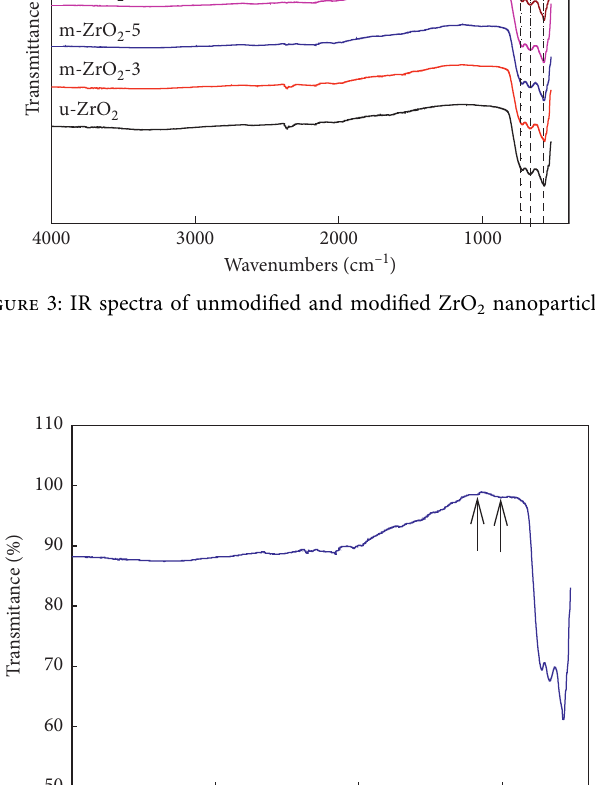
2 -5 nanoparticles.